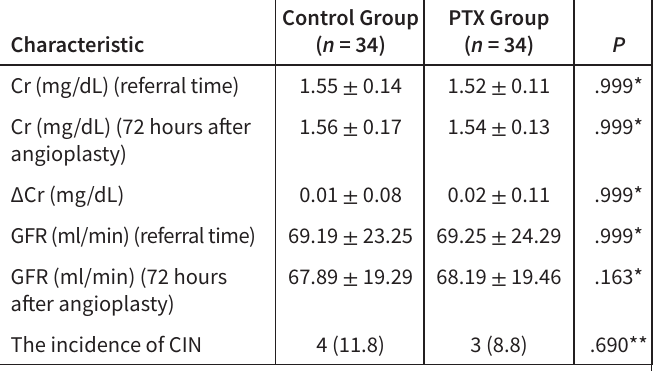
Table 2. Level of Serum Creatinine in Referral Time, after 72 Hours of Angioplasty, and Changes (Δ) in the PTX Supplementation and Control Groups